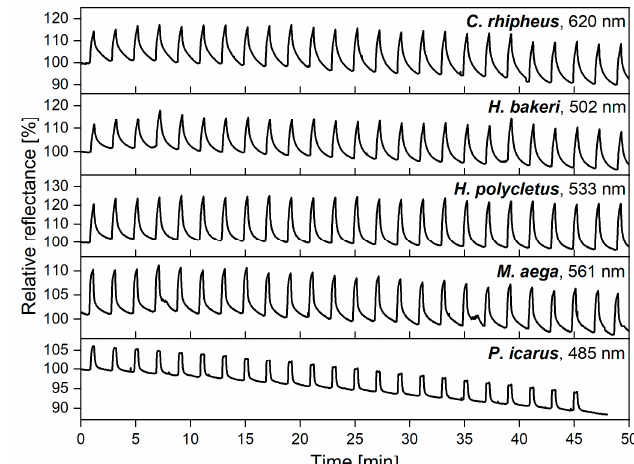
Figure 2. Vapor pulses (30 s, 50% ethanol) were applied to the wings of five investigated species, which was followed by 90 s purging with synthetic air. The process was repeated more than 20 times, and the maximum of the spectral response was plotted as a function of time. The nanometer values in the top right corners show the wavelength of the maximal spectral responses from which the time-dependent signals were generated.